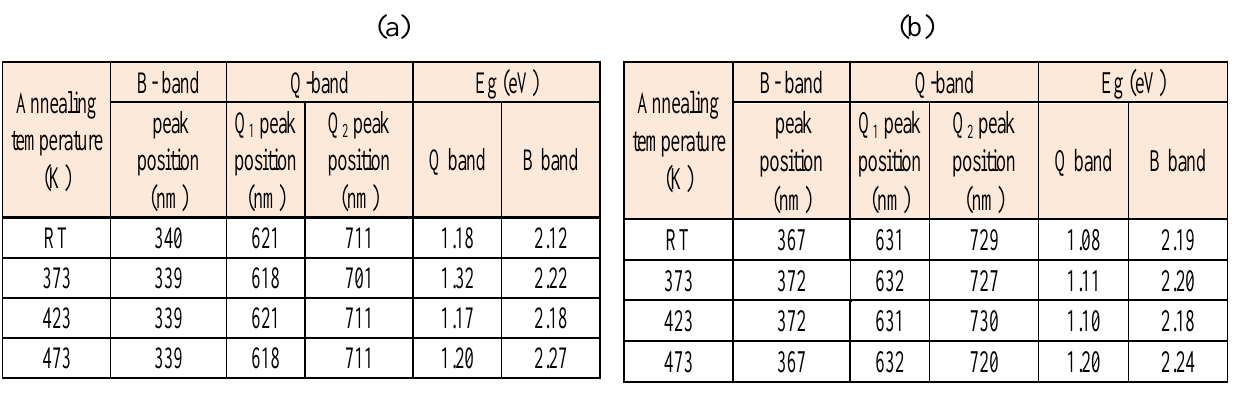
to NiPc (a) (100/1), (b) (100/10), and (c) 60